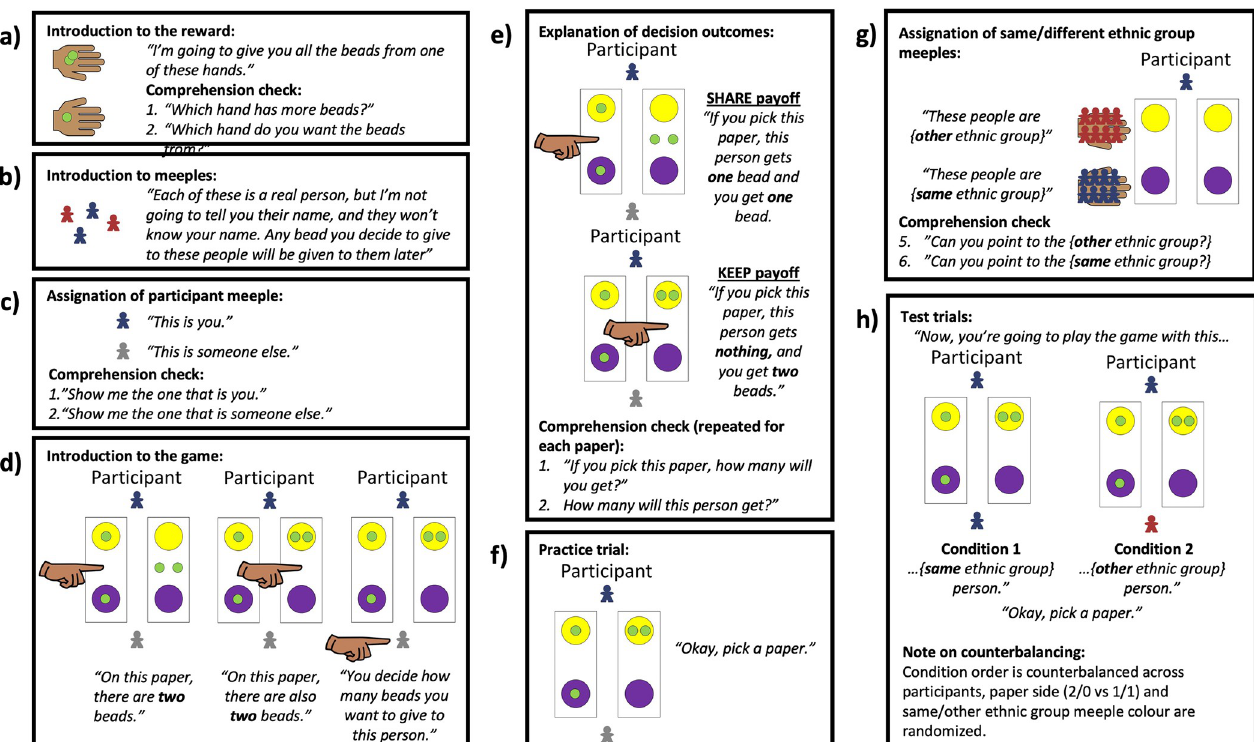
Fig 1. Dictator Game procedural details. a) introduction to reward; b) introduction to meeples and emphasis on their representation of real people; c) assignation of participant’s meeple colour; d) introduction to game play; e) explanation of decision outcomes; f) practice trial; g) assignation of same/different ethnic group meeples; h) test